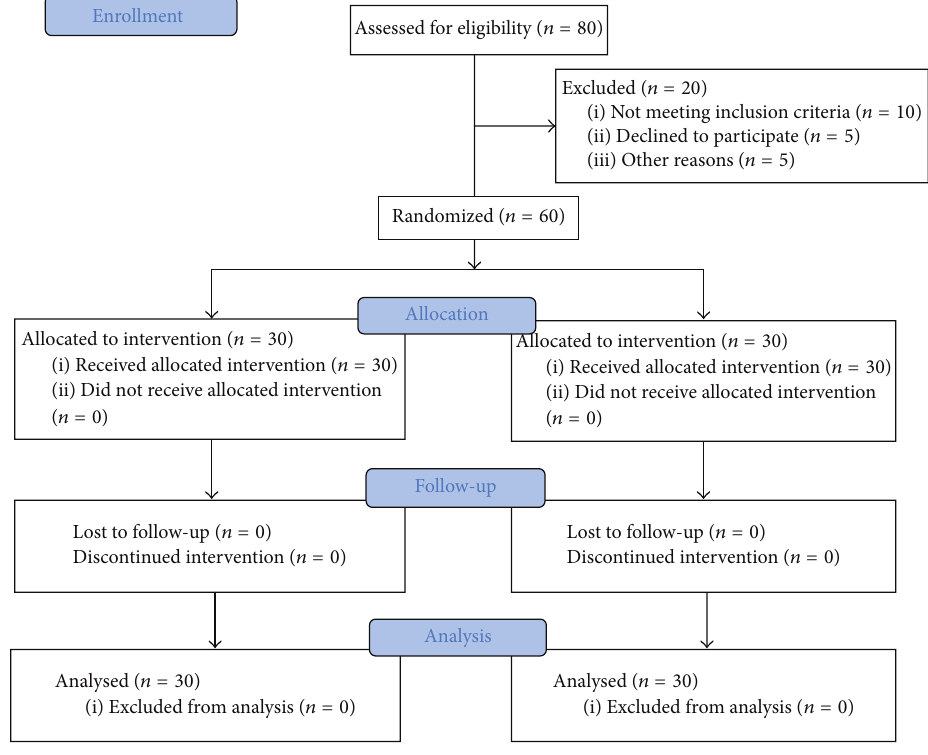
Figure 1: Consort diagram.